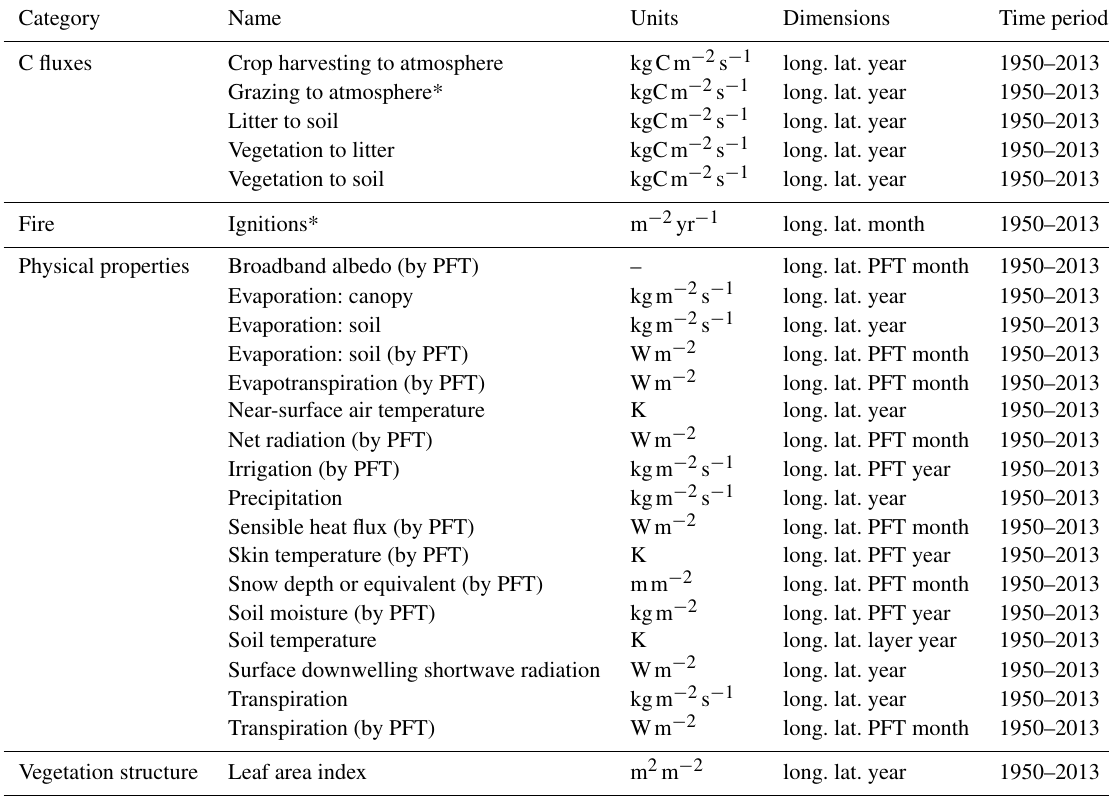
Table A1. Second-priority output variables. See Table 3 for primary model outputs.